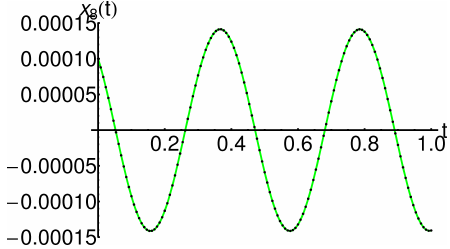
Fig. 8. Comparison between the approximate solutions ¯ x 8 given by Eq. (35) and the corresponding numerical solutions